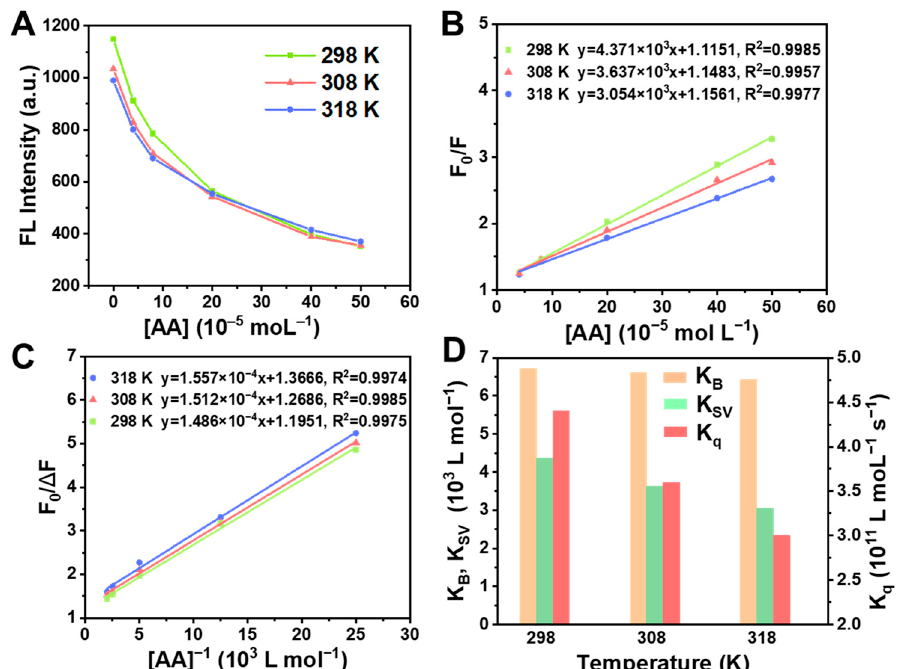
Figure 4. ( A ) Effect of temperatures on fluorescence intensity. ( B ) Stern–Volmer plots of fluorescence quenching of BSA by AA at three different temperatures. ( C ) Lineweaver–Burk curves of fluorescence quenching of BSA by AA at three different temperatures. ( D ) K B , K SV and K q values at three different temperatures.